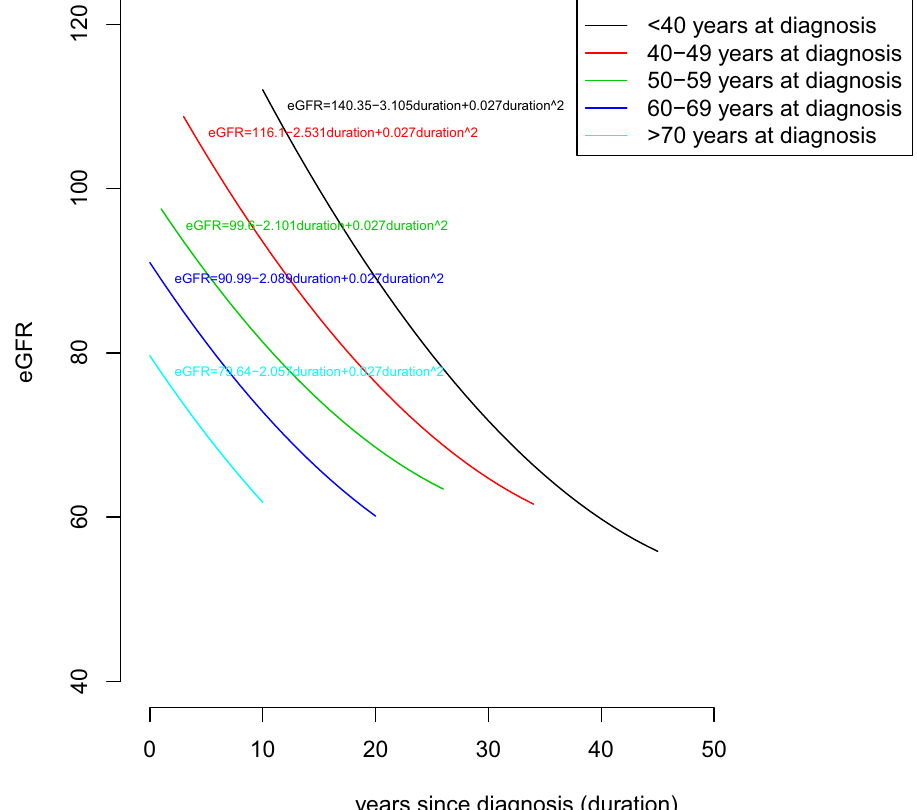
Figure 1. Estimated trajectories of log-transformed estimated glomerular filtration rate (eGFR) levels according to known diabetes duration based on Model 1, stratified by known age-of-onset of